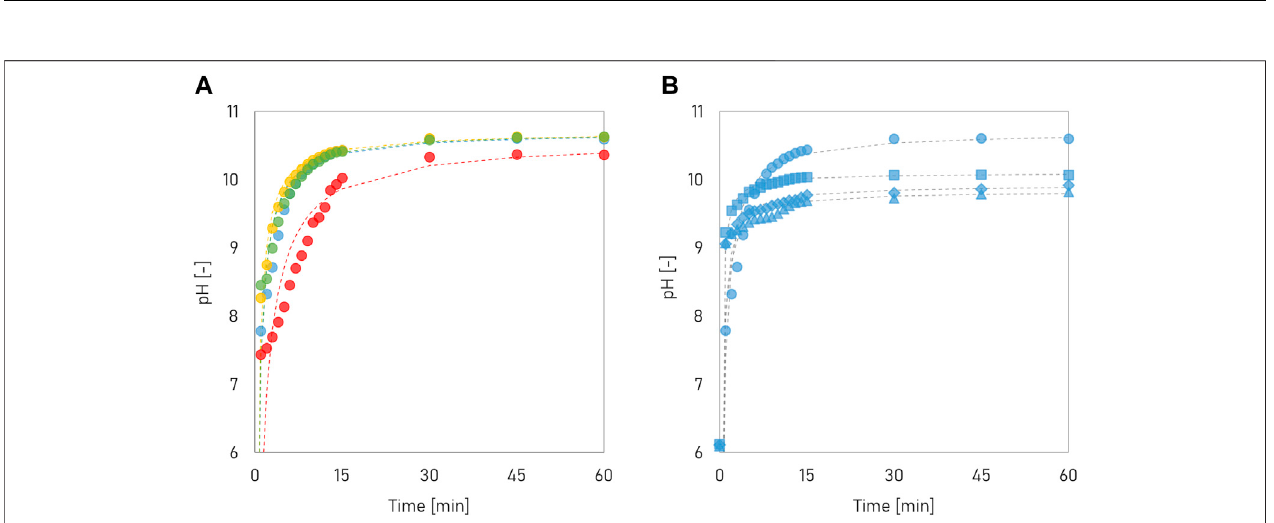
FIGURE 8 | Mg(OH) 2 dissolution kinetics in (A) fresh urine and (B) concentrated fresh urine. Data points show experimentally determined average pH values and dashed lines represent fi rst order kinetic fi t by linear regression and plotted using rate constants shown in Table 2 . For fresh urine, four urine compositions were used: FU 1 (blue), FU 2 (red), FU 3 (yellow) and FU 4 (green). For concentrated fresh urine, FU 1 was dehydrated to make CFU ×2 ( ▪ ), CFU ×4 ( ◆ ) and CFU ×8 ( ▲ ).